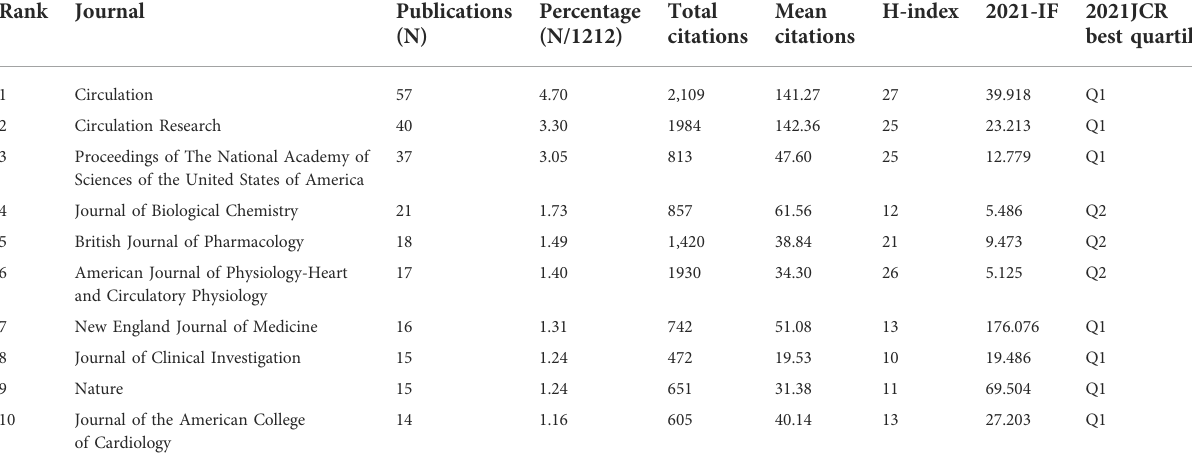
TABLE 3 Top 10 journals with published papers in cardiovascular research of sGC stimulators. Rank